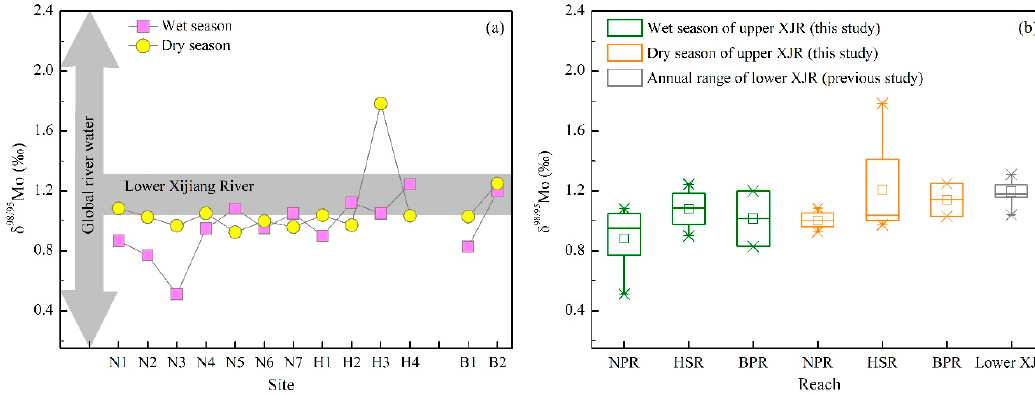
Figure 3. Seasonal and spatial variations in Mo isotopic composition of the upper Xijiang River; ( a ) the δ 98/95 Mo values along the upper XJR; ( b ) the box plot of δ 98/95 Mo values in different reaches of upper XJR.